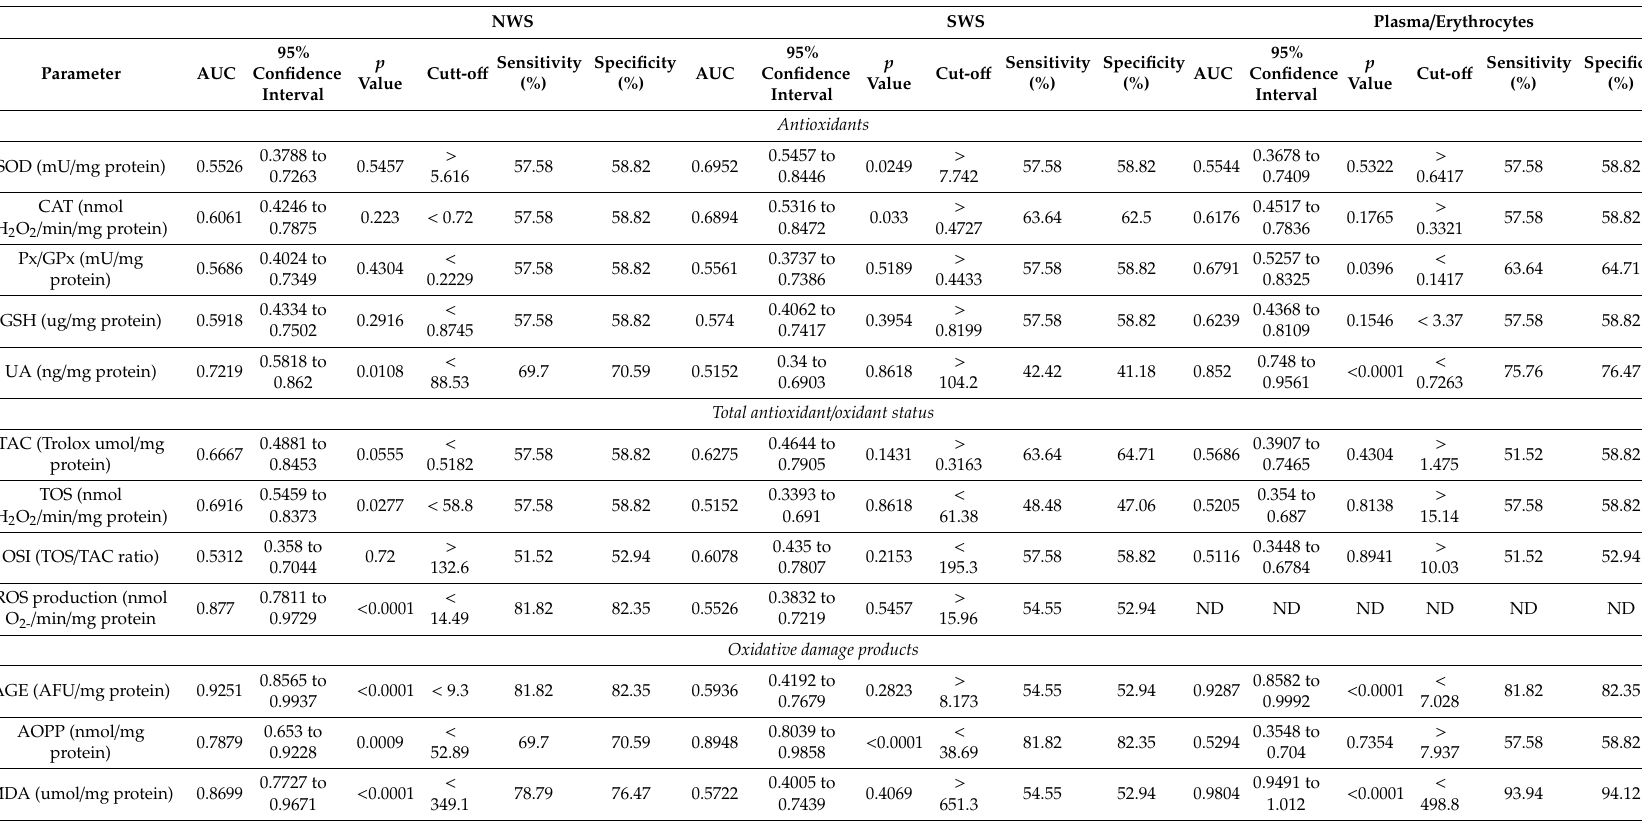
Table 3. Receiver operating characteristic (ROC) analysis of oxidative stress biomarkers in non-stimulated and stimulated saliva as well as plasma / erythrocytes of NYHA II and NYHA III